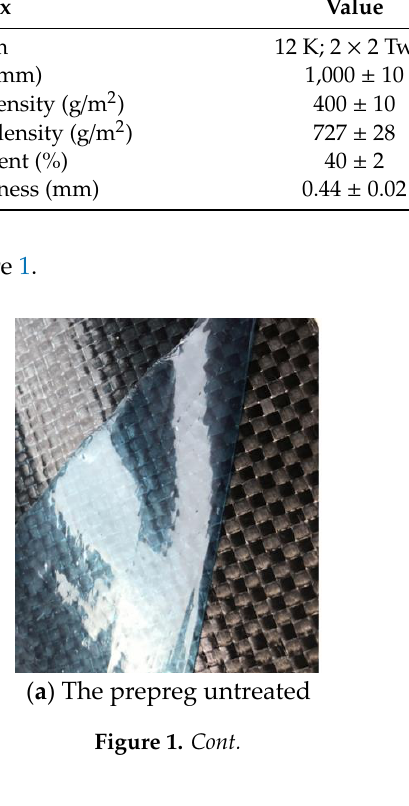
Table 1. The characteristic parameters of the prepreg.